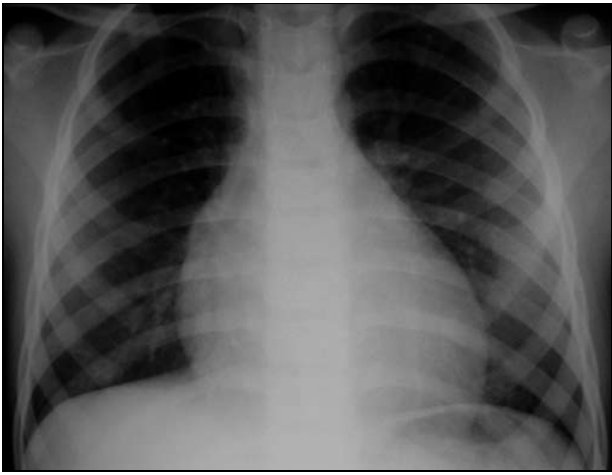
Fig 1. Plain radiograph of the chest demonstrating a bifid 4th rib on the left.